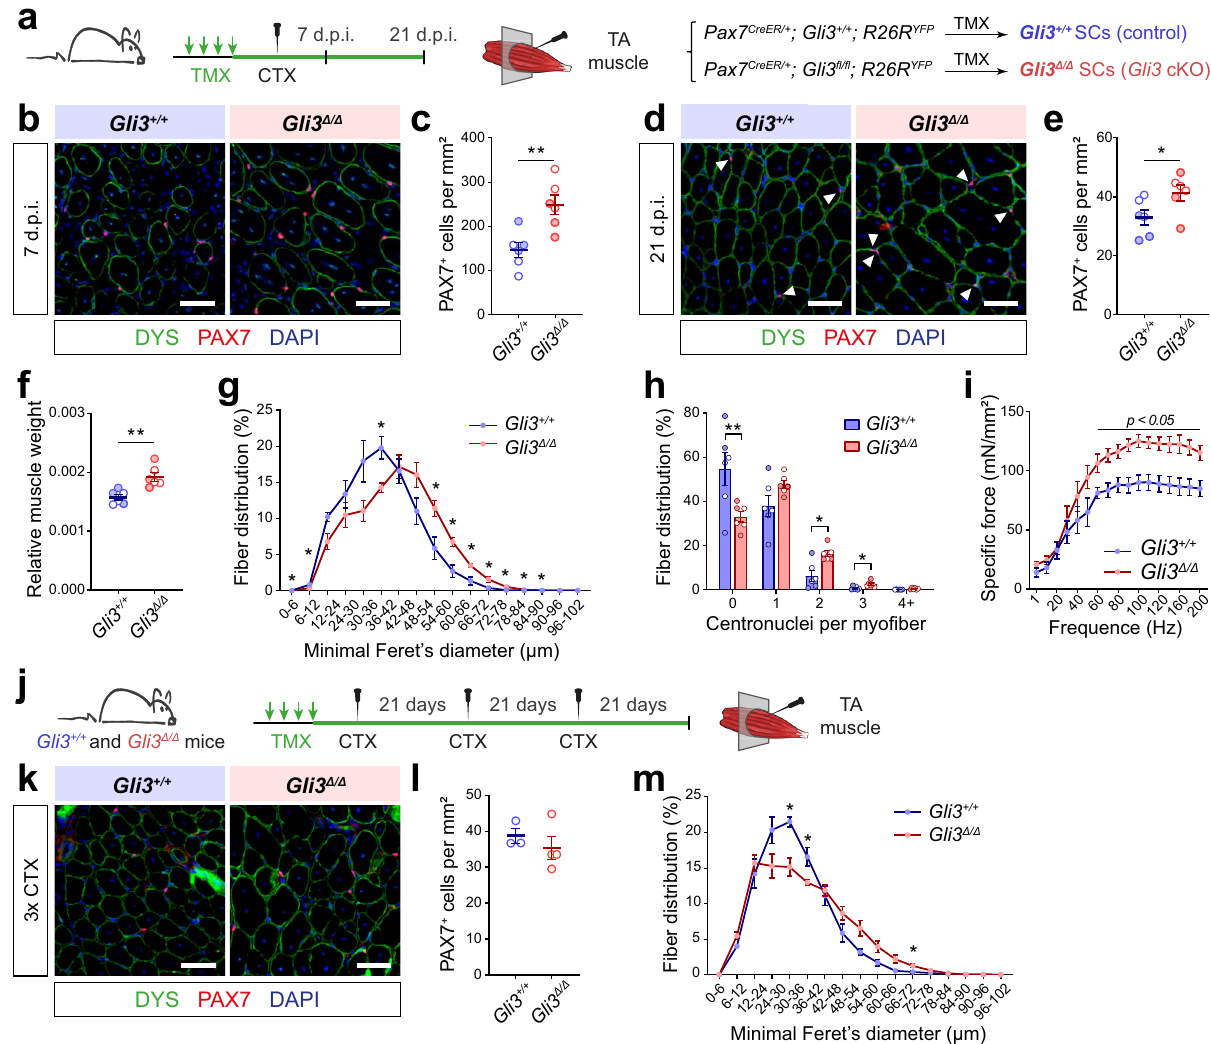
Fig. 3 Gli3 deletion in satellite cells enhances muscle regeneration. a Experimental design to analyze cardiotoxin (CTX)-induced muscle regeneration of Gli3 + / + and Gli3 Δ / Δ mice. b Representative images of TA muscle sections at 7 days post-injury (d.p.i.). Satellite cells (SCs) are labeled with PAX7 (red). DYSTROPHIN (DYS, green) delineates regenerating myo fi bers. c Quanti fi cation of PAX7 + SCs per mm² TA section at 7 d.p.i. d Immunostaining of PAX7 (red) and DYSTROPHIN (green) on TA sections at 21 d.p.i. e Quanti fi cation of PAX7 + SCs per mm² TA section at 21 d.p.i. f TA muscle weight normalized to total body weight. g TA myo fi ber distribution according to minimal Feret ’ s diameter. h Regenerated TA myo fi ber distribution according to their number of centrally located nuclei (centronuclei) at 21 d.p.i. i Speci fi c force of regenerated TA muscles at 21 d.p.i. j Experimental design to analyze regeneration of Gli3 + / + and Gli3 Δ / Δ mice following three consecutive CTX-injuries in the TA muscle (3xCTX). k Immunostaining of PAX7 (red) and DYSTROPHIN (green) on TA muscle sections following 3xCTX. l Quanti fi cation of PAX7 + SCs per mm² 3xCTX injured TA section. m Regenerated TA myo fi ber distribution according to minimal Feret ’ s diameter. DAPI stains nuclei (blue). Scale bars, 50 µ m. n = 6 (three males, empty dots, and three females, colored dots) for panels c , e , f , g , h , n = 5 males for each genotype for panel i , n = 3 Gli3 + / + males and 4 Gli3 Δ / Δ males for panels l , m . Means ± SEM; Unpaired t -test with Welch ’ s correction for panels c , e , f , h , l , Multiple unpaired t -test for panels g , i , m , * p < 0.05; ** p <